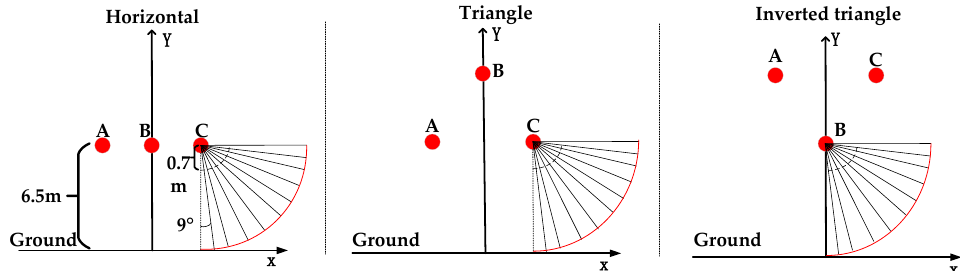
Figure 13. The flight area is divided into equal intervals. A: A-phase transmission line; B: B-phase transmission line; C:C-phase transmission line